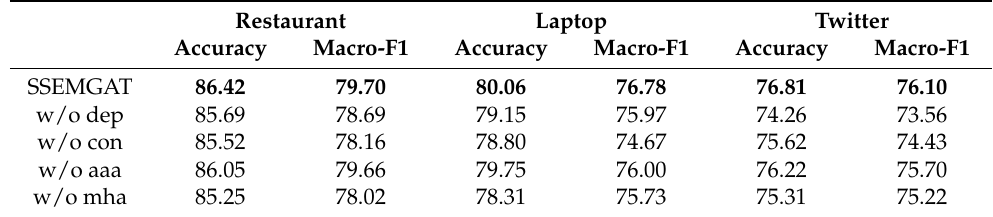
Table 5. The results of the ablation study.